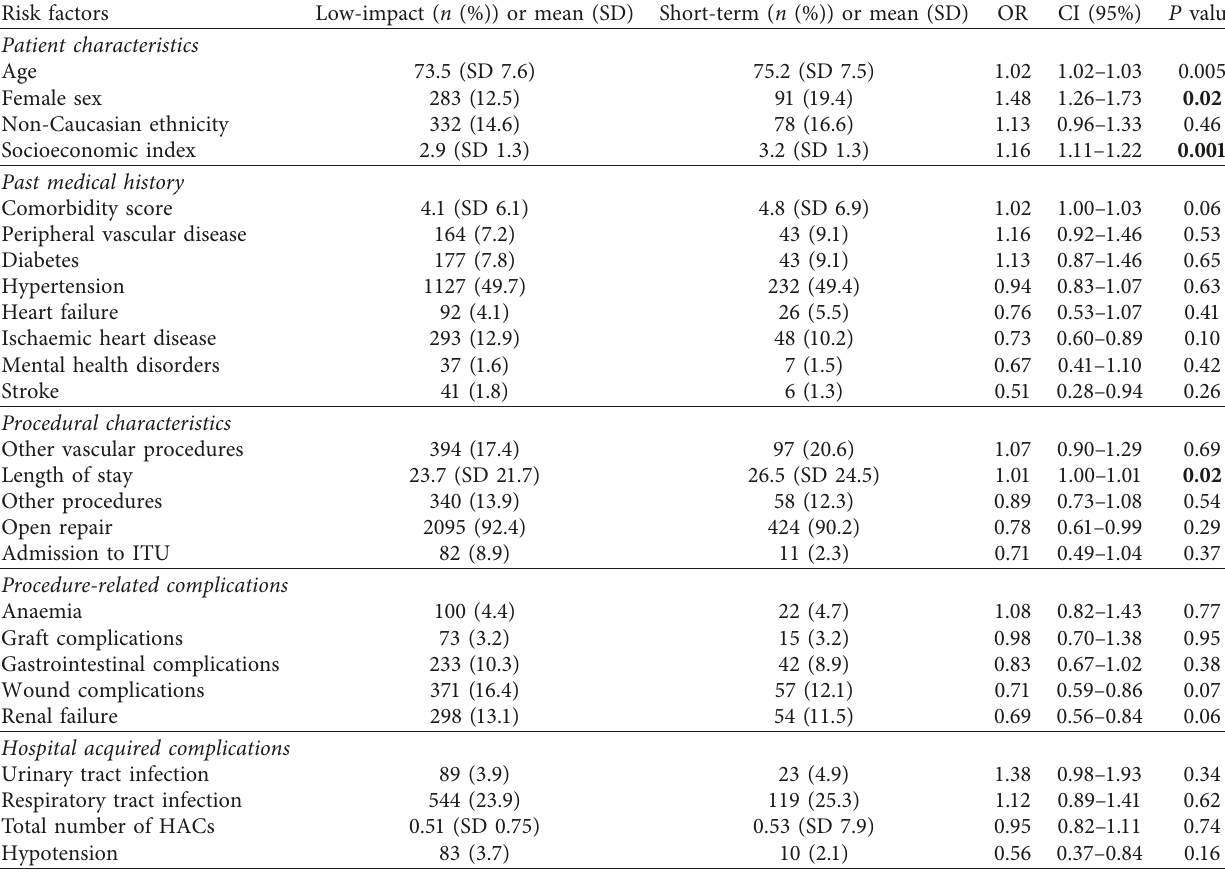
Table 3: Covariates associated with Group 3 (short-term high-impact) as compared to low-impact users among patients who had rAAA repair.